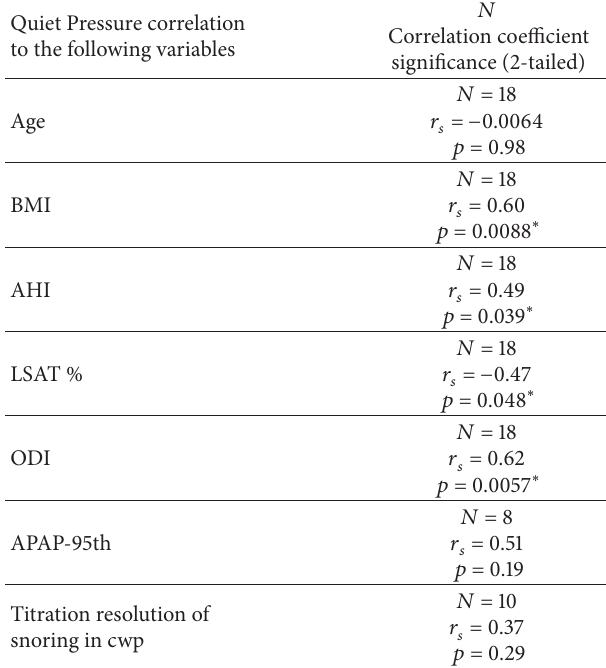
Table 4: Spearman’s rank correlation coefficient based on the Five-Minute CPAP Test Quiet Pressures versus other variables. ∗ Statistical significance with 2-tailed 𝑝 < 0.05 . % = percent; AHI = apnea-hypopnea index; APAP-95th = Auto-CPAP devices’ 95th